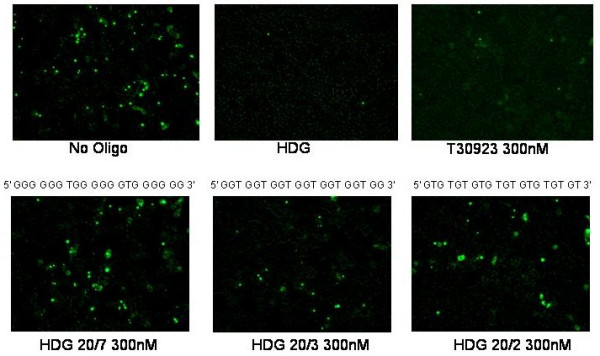
The indicated ODN was co-transfected with p72Q and the cells photographed 48 hours later under dark field. The upper left panel represents a reaction lacking oligonucleotide.